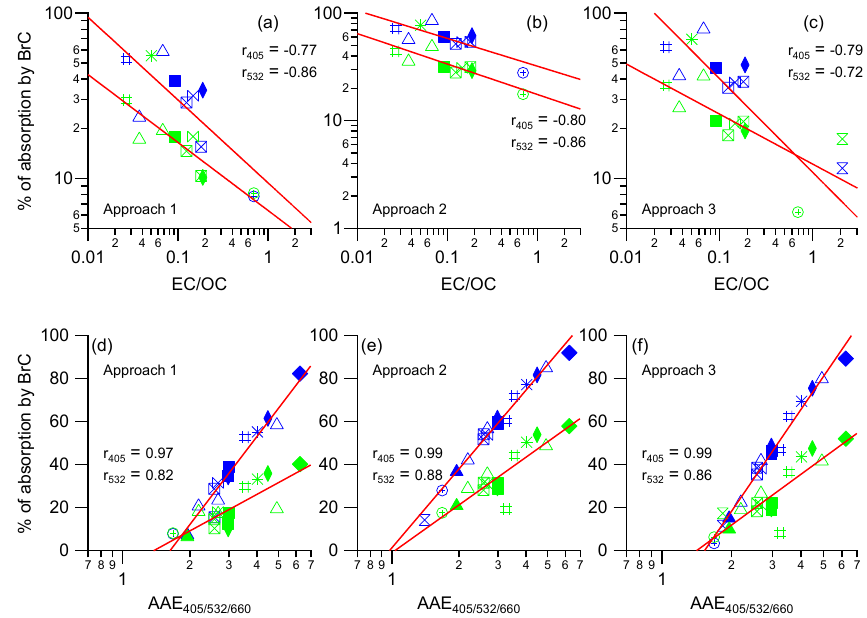
Figure 8. Percentage of absorption due to BrC vs. EC / OC – (a) for approach 1, (b) for approach 2, and (c) for approach 3. Blue symbols are for 405nm and green symbols are for 532nm. Panels (d) – (f) are the same as the top row of data except vs.